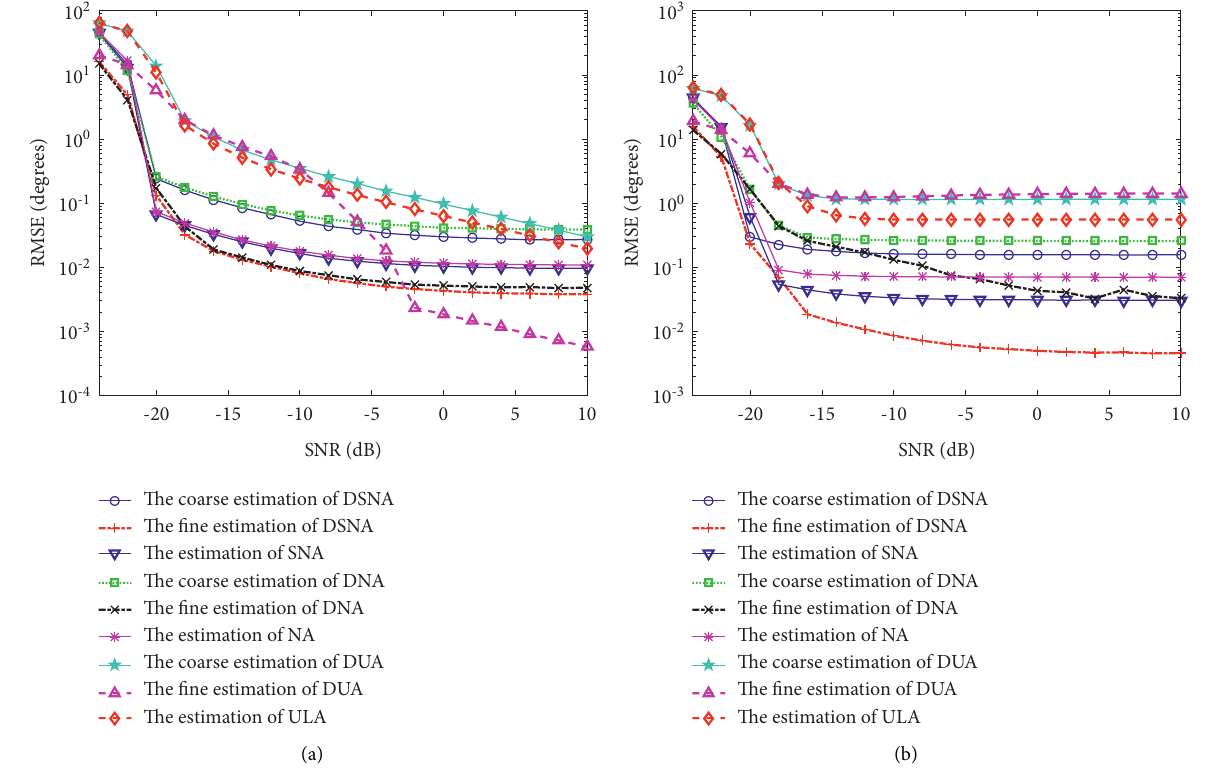
Figure 10: Multiple-source signals and d � λ /4; the baseline length is 60 times the wavelength. (a) Not considering mutual coupling between the array antennas. (b) Considering mutual coupling between the array antennas.